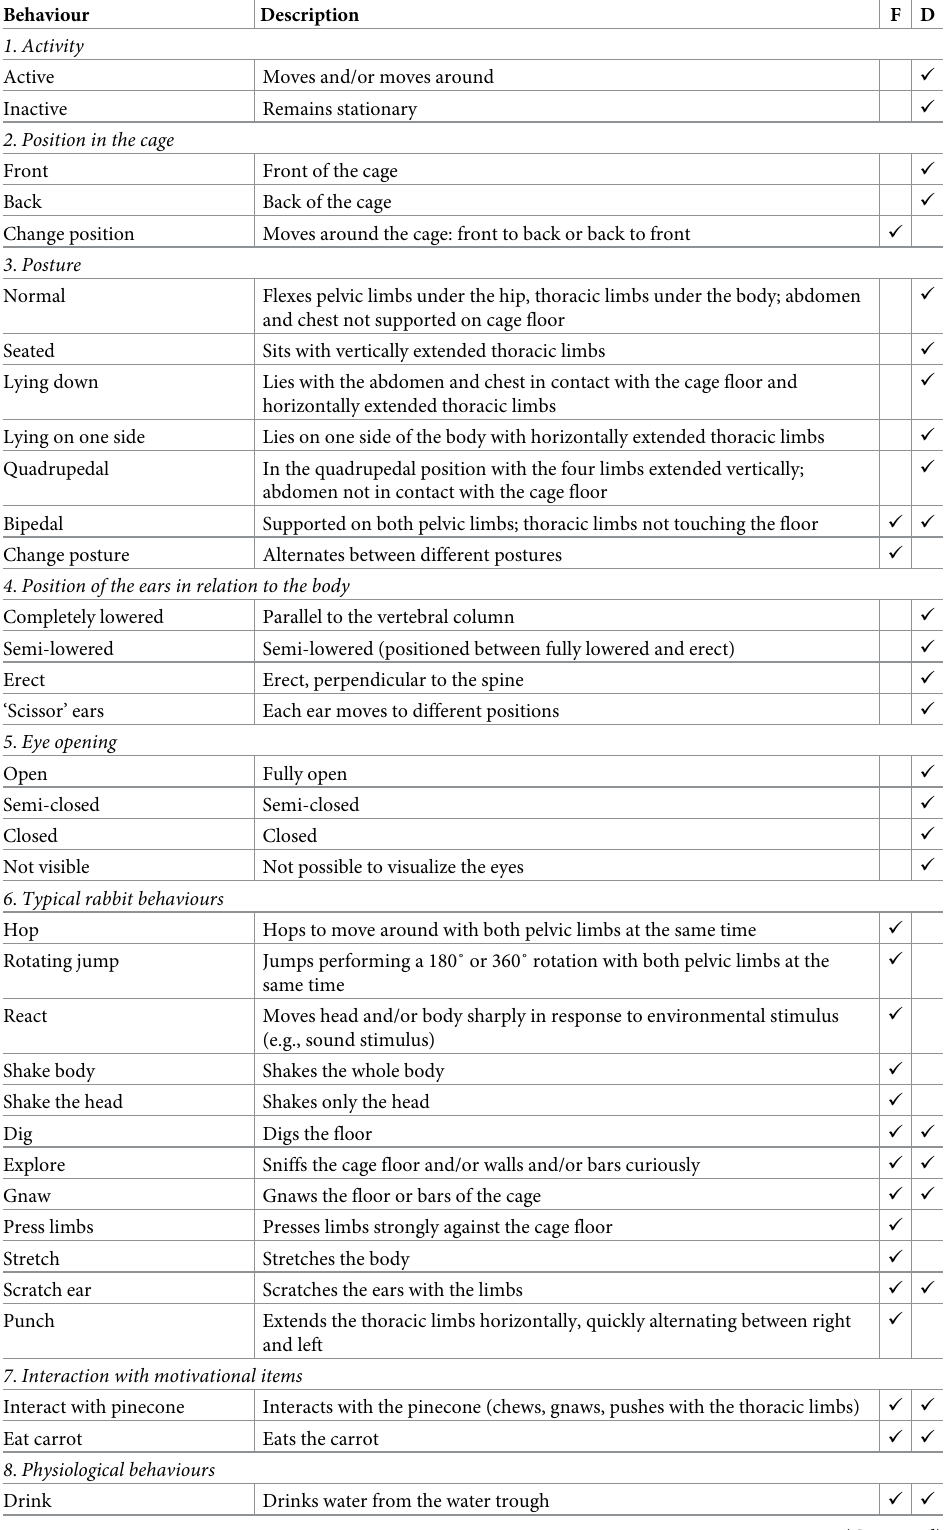
Table 2. Ethogram of rabbits undergoing orthopaedic